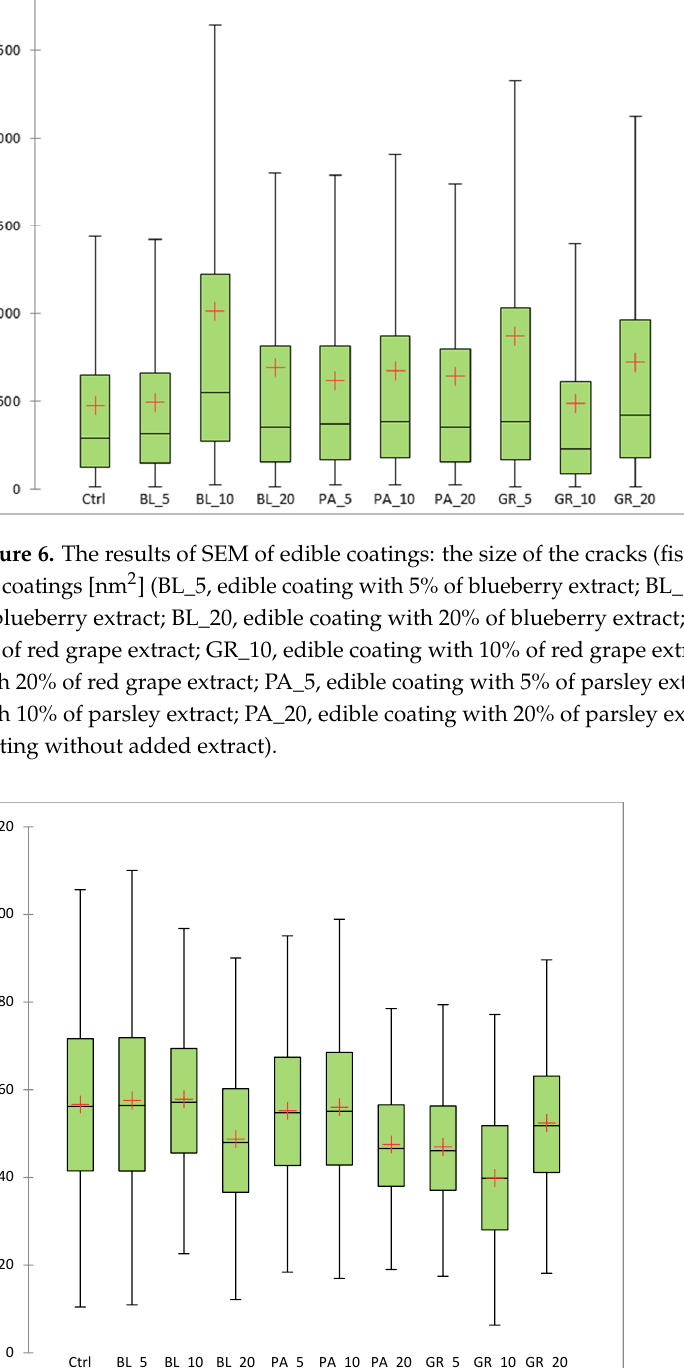
Figure 7. The results of SEM of edible coatings: the distance between cracks in the surface of the coatings (nm) (BL_5, edible coating with 5% of blueberry extract; BL_10, edible coating with 10% of blueberry extract; BL_20, edible coating with 20% of blueberry extract; GR_5, edible coating with 5% of red grape extract; GR_10, edible coating with 10% of red grape extract; GR_20, edible coating with 20% of red grape extract; PA_5, edible coating with 5% of parsley extract; PA_10, edible coating with 10% of parsley extract; PA_20, edible coating with 20% of parsley extract; Ctrl, control = edible coating without added extract). The distance between the cracks has a direct correlation to the total area R = 0.71 ( p < 0.05). The larger the area, the smaller the distance between the cracks. A linear dependence of the increasing concentration on the distance between cracks was not confirmed. A dis- tance between cracks (56.66 nm on average) was found in the control sample, without any significant difference as compared with samples BL_5 (57.61 nm on average), PA_5 (55.24 nm on average) and PA_10 (56.03 nm on average) (p ˃ 0.05). In the other samples, a statis- tically significant difference ( p < 0.05) vs. the control was observed in the distance between cracks. Although the formation of cracks on the surface of the coating was proven at a mag- nification of 80 K, the cracks did not significantly interfere with the profile of the coating material. The transverse refractive indices did not document any cracks going through the whole layer (Figure 5). This means that the protective function of the edible coating was not disrupted by the added plant pomace. Khorram et al. [47] confirmed the presence of fractures and uneven surface at the addition of 3.5% Persian gum and 5% gelatine at as low a magnification as 500. It is therefore possible to assume that, unlike the addition of polymers, such as Persian gum and gelatine, the addition of pomace does not result in a change in the integrity of the full width of the formed coating but only on its surface. The obtained micrographs of the analysed coatings also showed the formation of an uneven surface during the handling of the samples (Figure 8). The information that the handling of the coating causes structural changes, manifested as the undulation of the surface, is an additional partial result of the study. A more suitable method for evaluation is the direct gel formation on the conductive target used in this study, which allows the assessment of the effect of the addition of pomace, rather than some accidental defor- mations caused during sample handling (transport, handling, refraction).